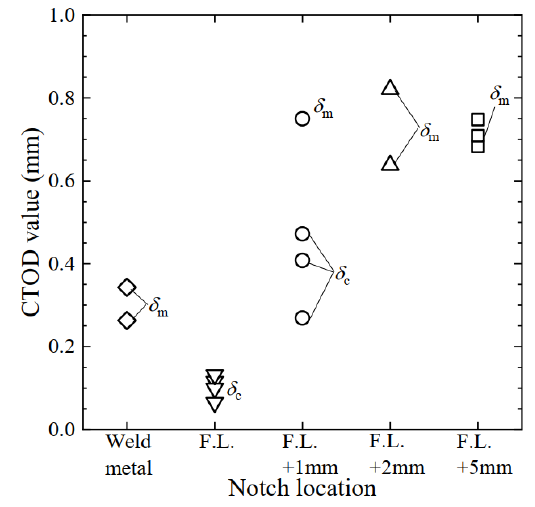
Figure 15. CTOD test results at each location welded using SAW of 3.5 kJ / mm (test temp. 273 K).